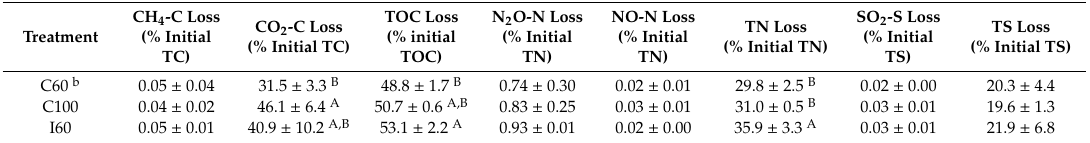
Table 2. C, N and S balance (values are means ± SD, n = 3) a